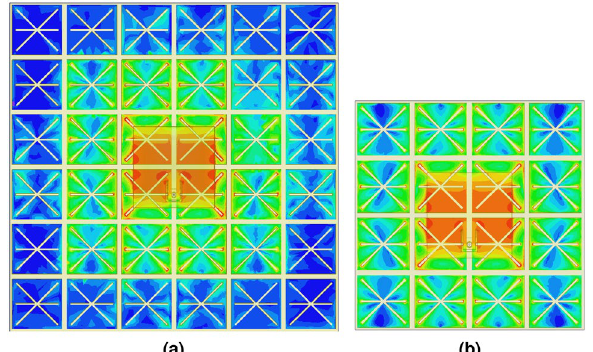
6 and ( b ) 4 4 element × ×